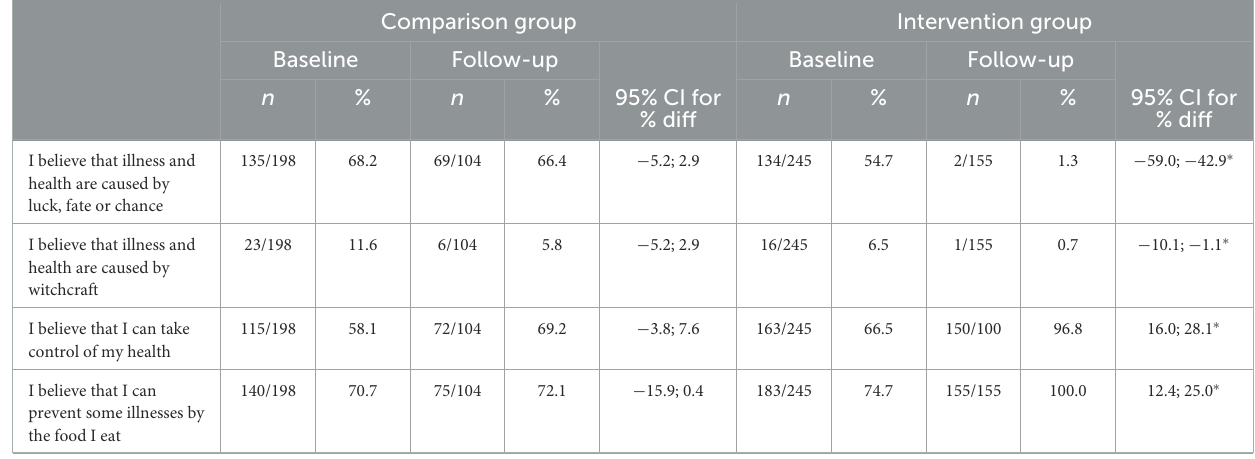
TABLE 3 Changes in health-related locus of control.